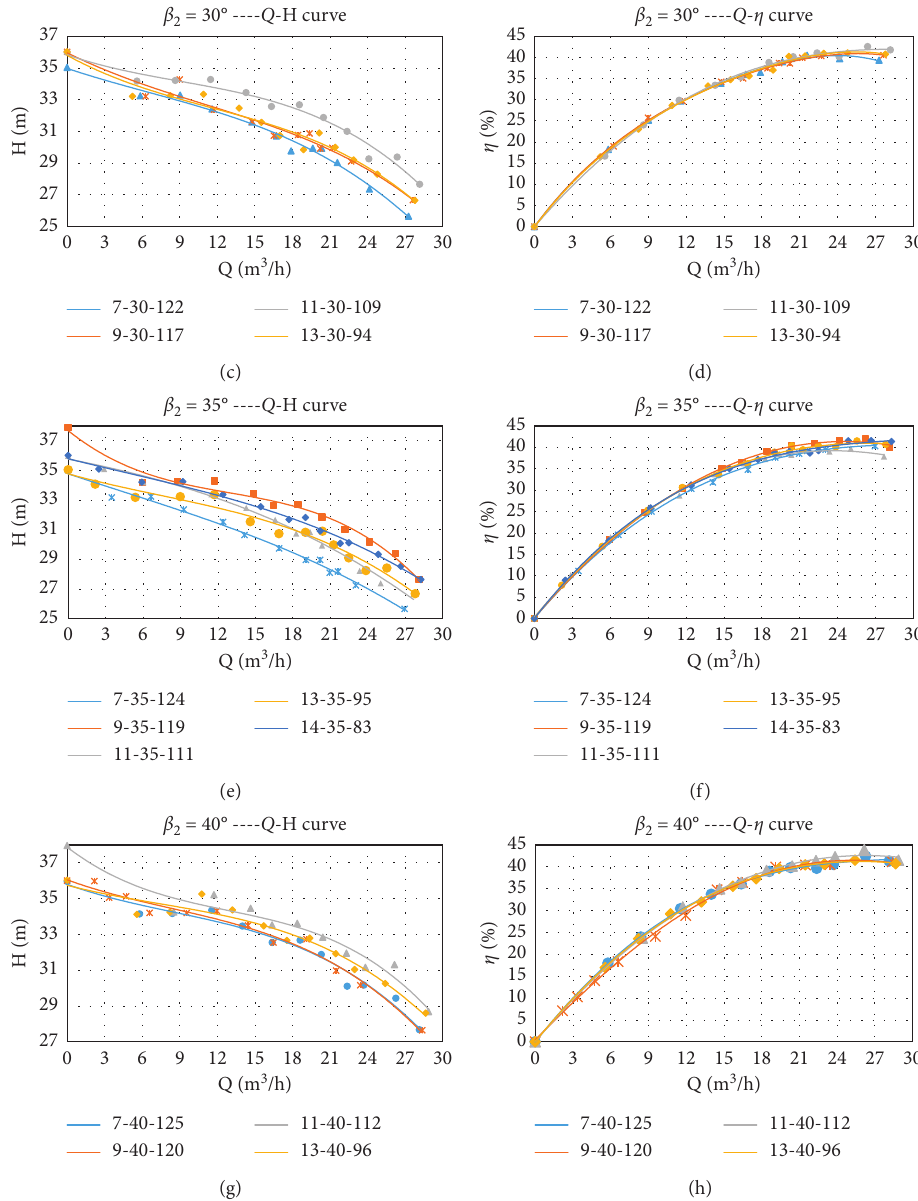
Figure 28: External characteristic curve of the plastic centrifugal